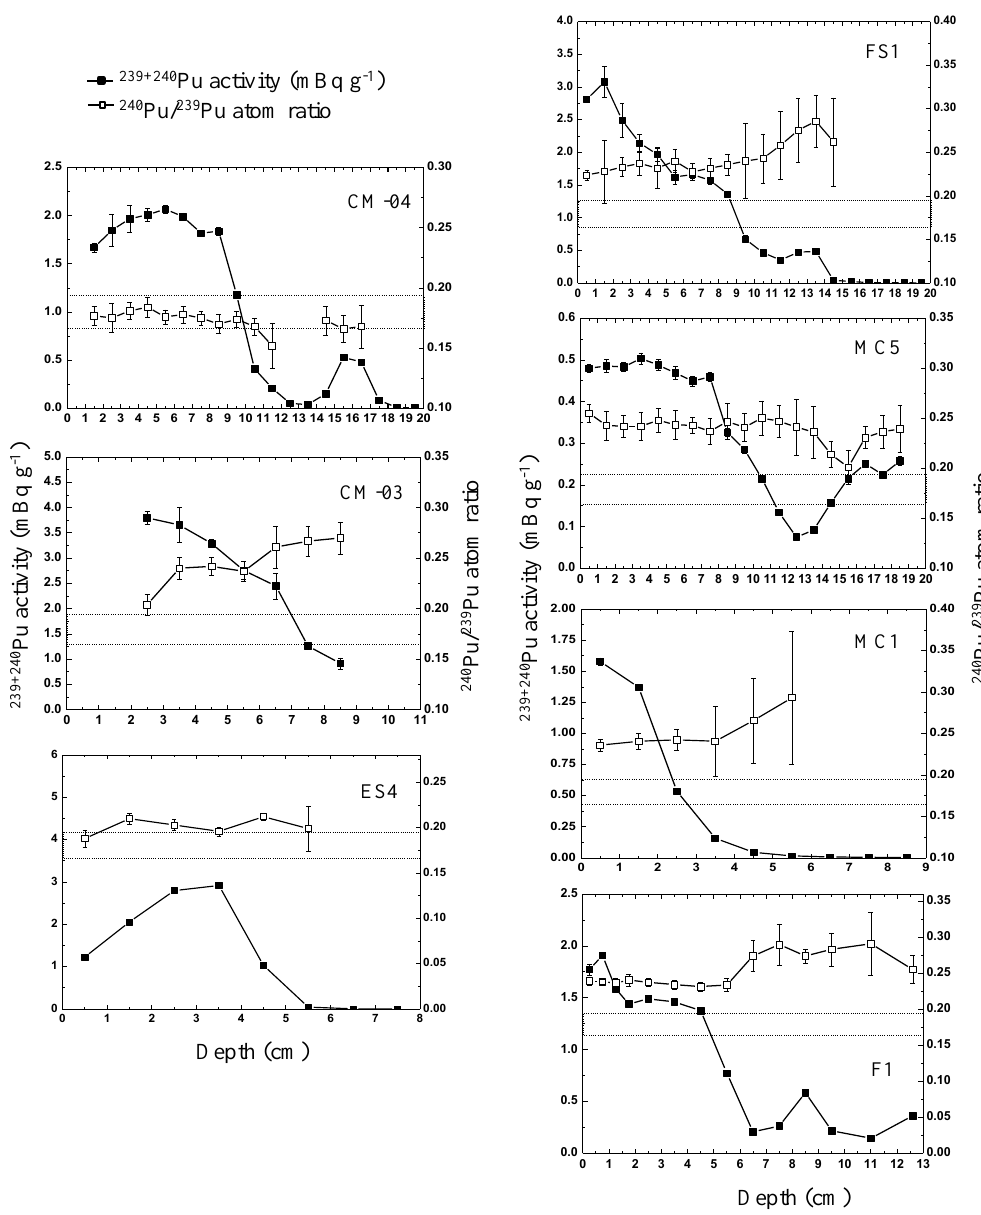
Fig. 4. Vertical profiles of 239 + 240 Pu activities and 240 Pu/ 239 Pu atom ratios in the sediment cores. The dashed lines indicate the 240 Pu/ 239 Pu atom ratio range of global fallout (0.180 ± 0.014). CM-03 and CM-04 are from Zheng and Yamada